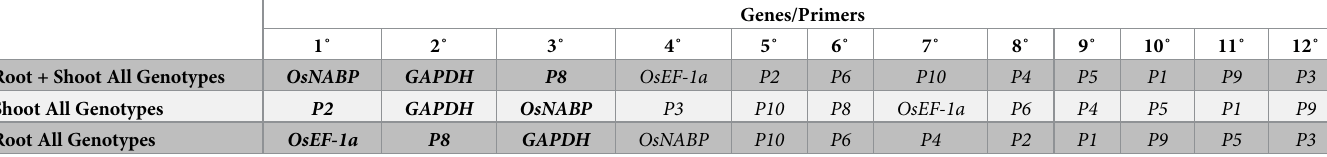
Table 4. Recommended comprehensive